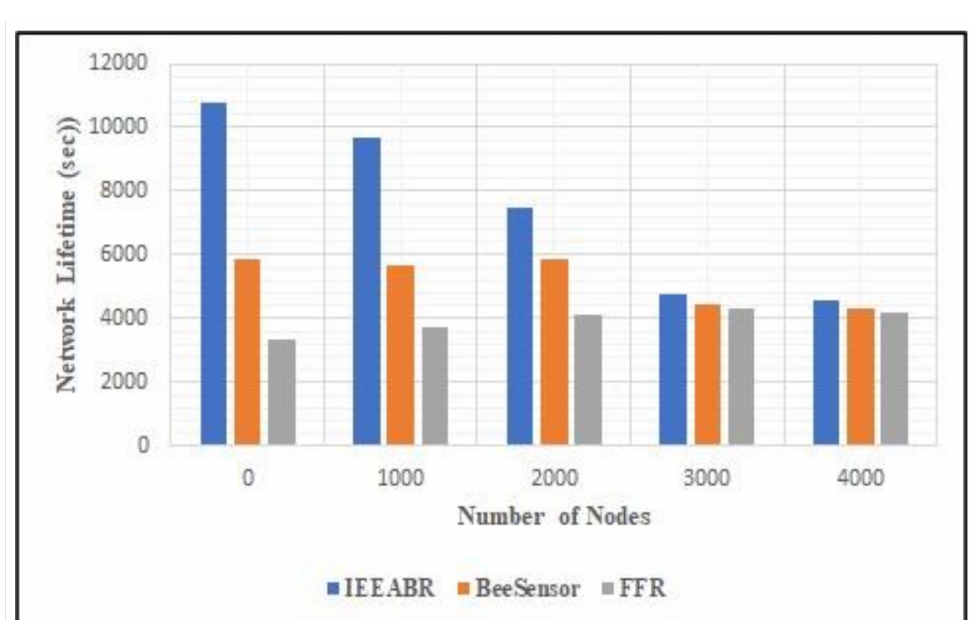
Figure 17. Network